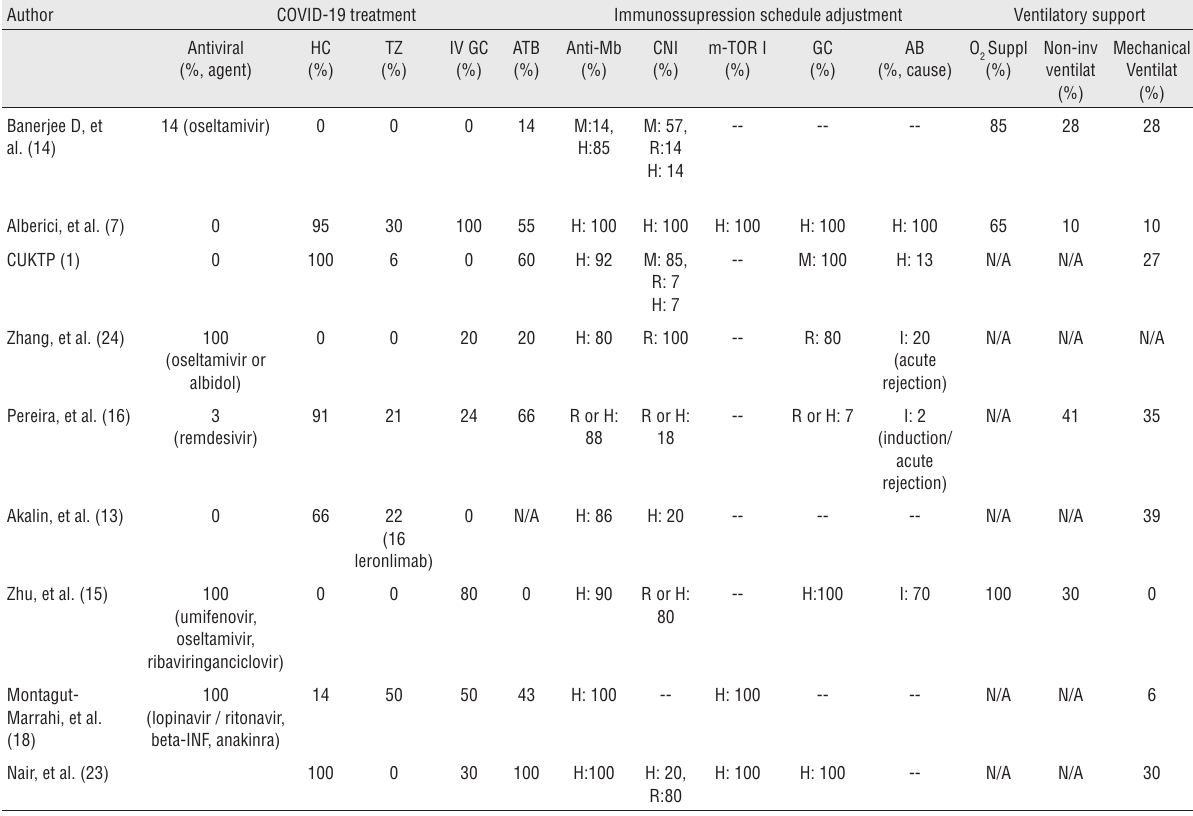
Table 3 - Summary of COVID-19 specific treatment, immunosuppression schedule adjustment, and ventilatory support